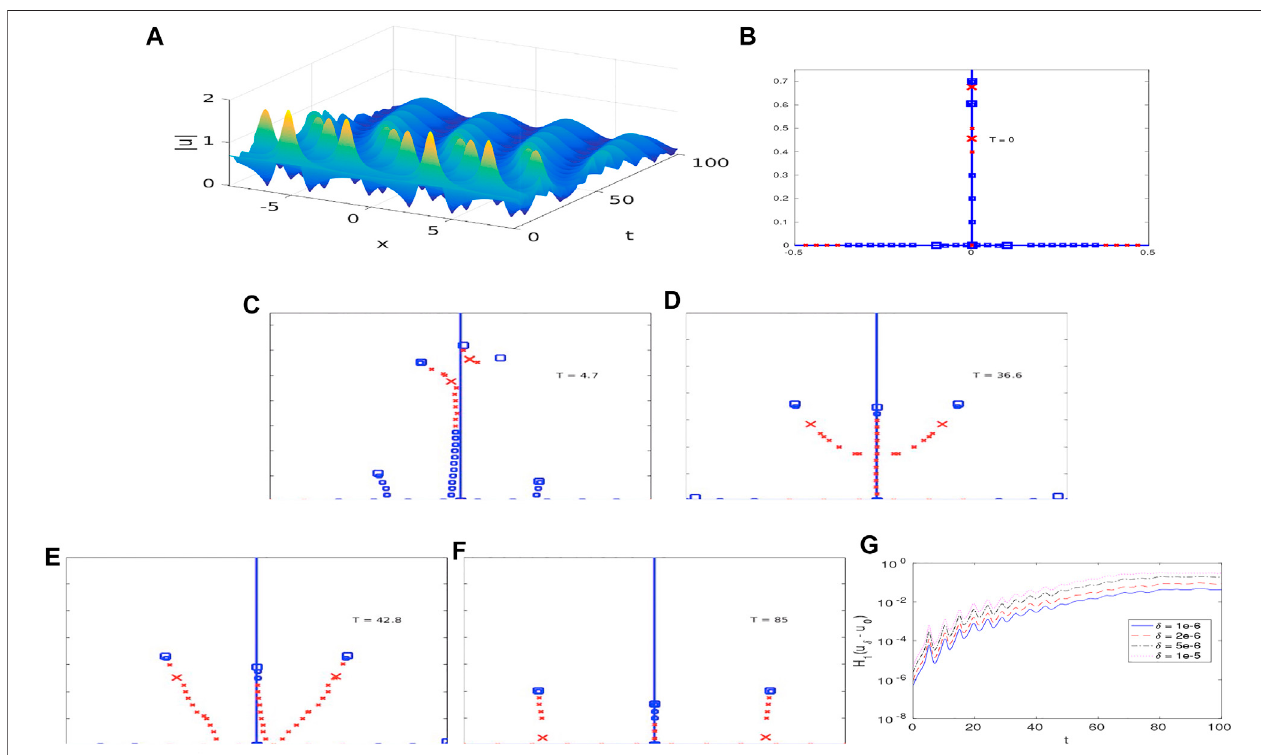
(cid:12)(cid:12)(cid:12)(cid:12)(cid:12) (cid:12)(cid:12)(cid:12)(cid:12)(cid:12) U ( 2 ) ε , c ( x , t ) for 0 ≤ t ≤ 100 and Spectrum at (B) t (cid:1) 0, (C) t (cid:1) 4 . 7, (D) t (cid:1) 36 . 6, (E) t (cid:1) 42 . 8, (F) t (cid:1) 85 and (G) η ( t ) for f 1 ( x , t ) ,